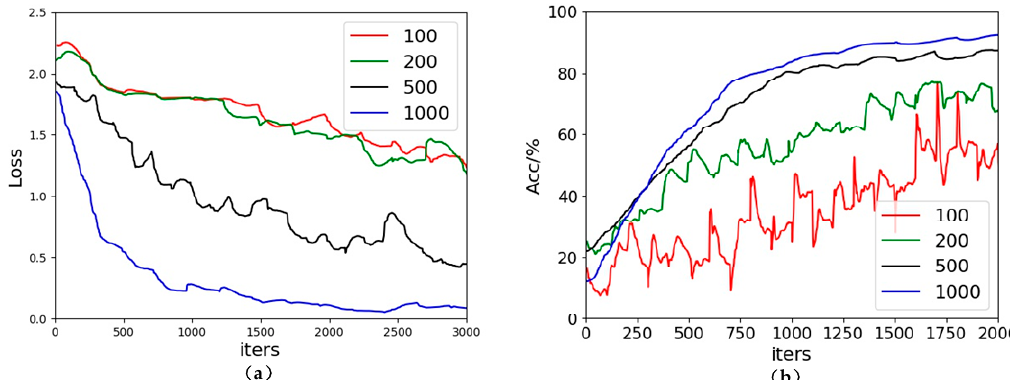
Figure 12. Average results of five tests under different data scales: ( a ) The loss during training; ( b ) the accuracy during training.